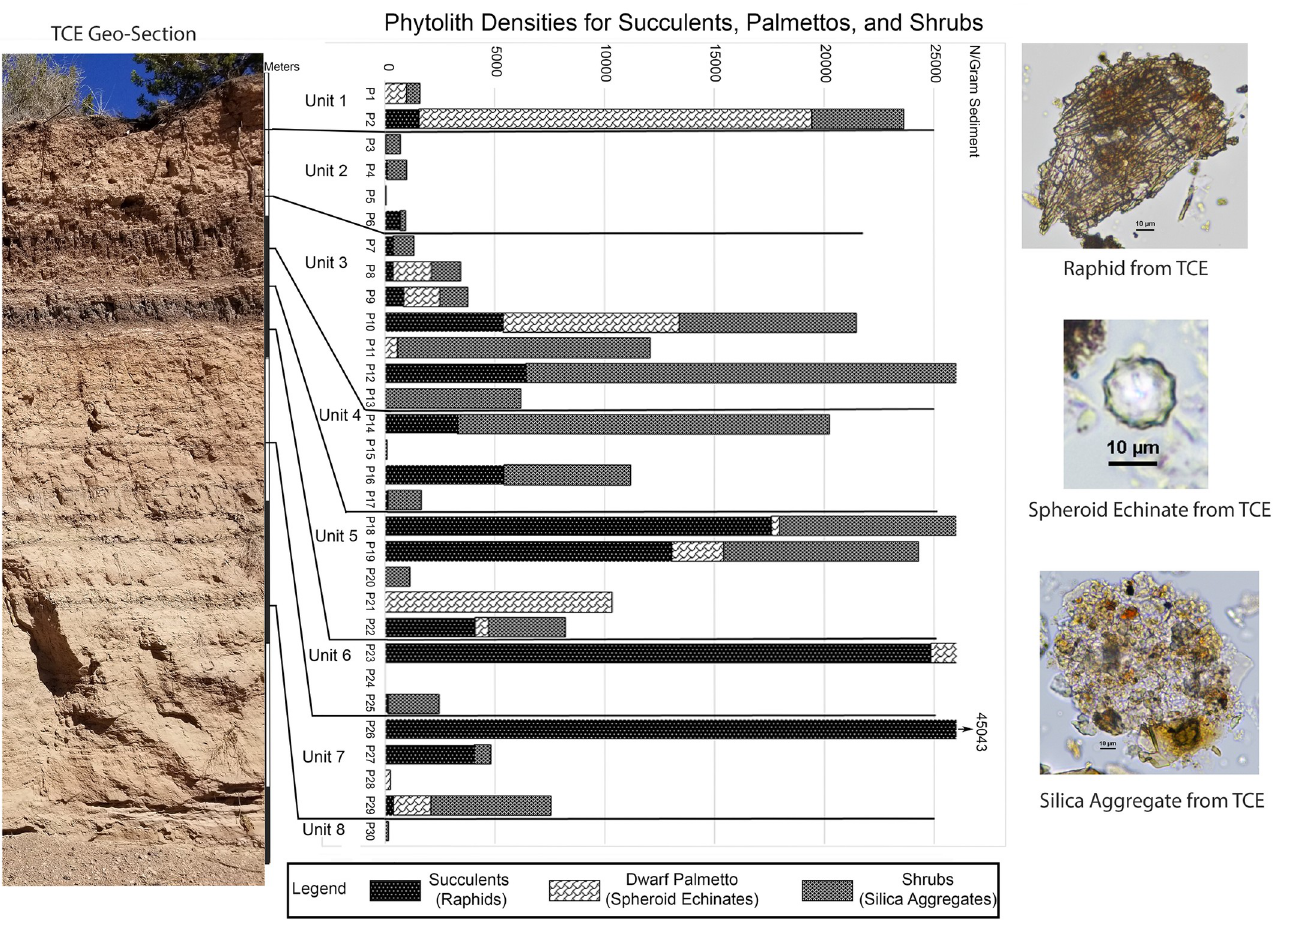
Fig 3. Tesuque Creek East Section showing with phytolith density results (n/gram). Phytolith densities are shown for proxies for shrubs, palmetto, and agave, as well as photos of these representative